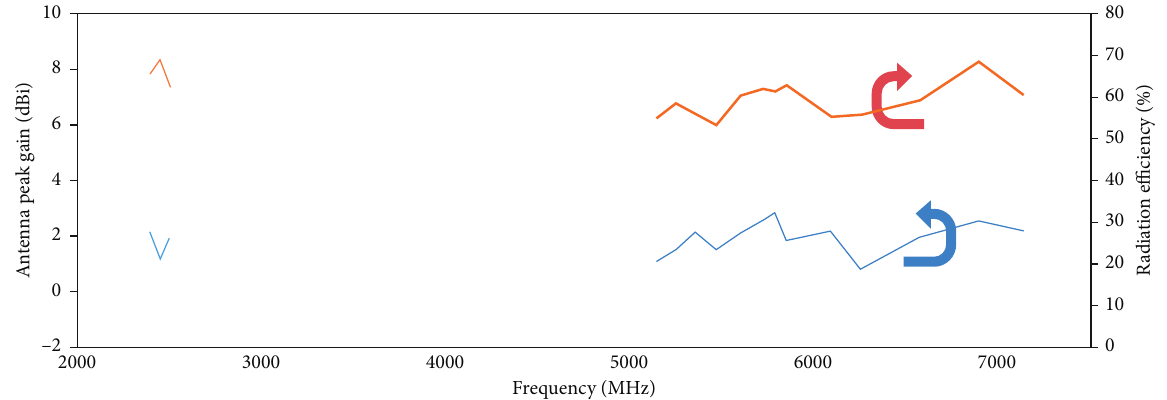
Figure 9: Two-dimensional radiation patterns of the antenna in the x - y , x - z , and y - z planes at (a) 2.450, (b) 5.16, (c) 5.825, and (d) 6.85GHz. 10